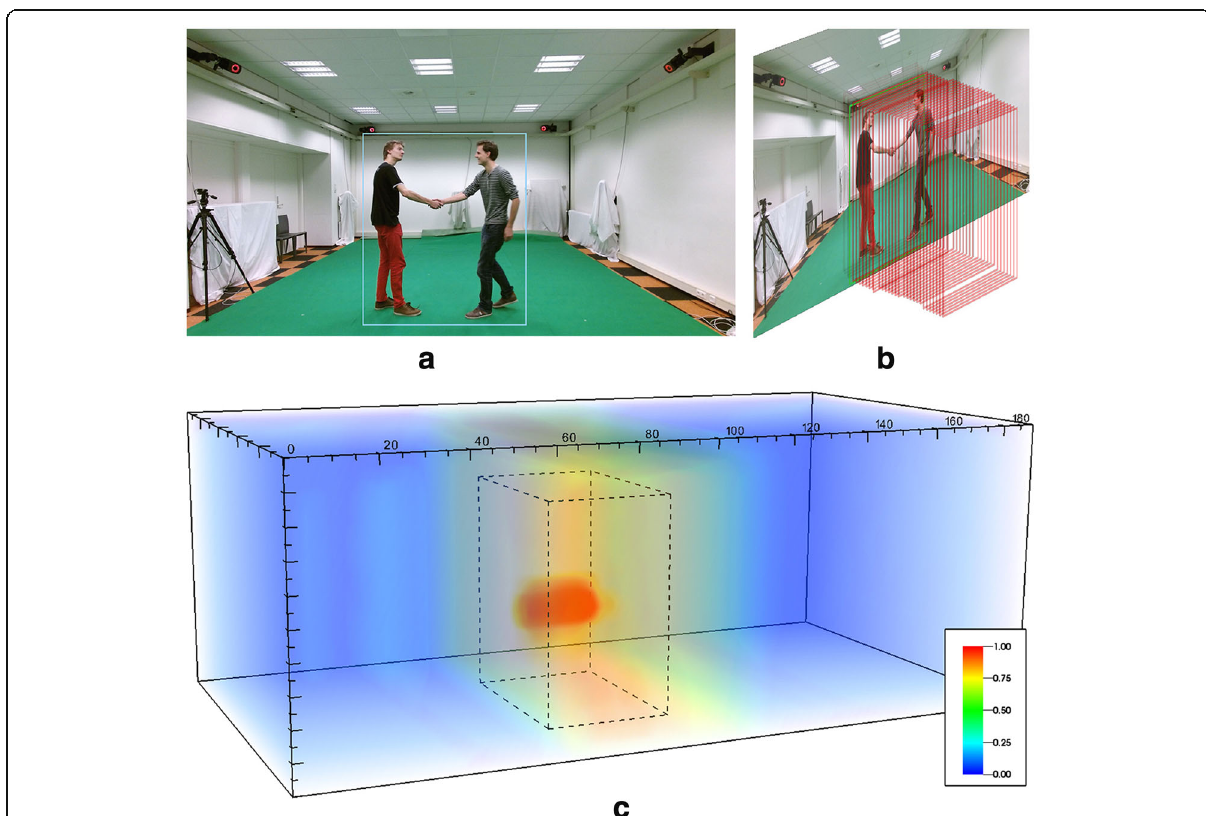
Fig. 5 Example frame of a handshake interaction ( a ). The Platt response space appears in ( c ). The localization tube is shown in ( b ), projected on the epitome frame. a Video frame with ground truth box (light blue). b Final detection tube. c Platt response space with the ground truth bounding volume